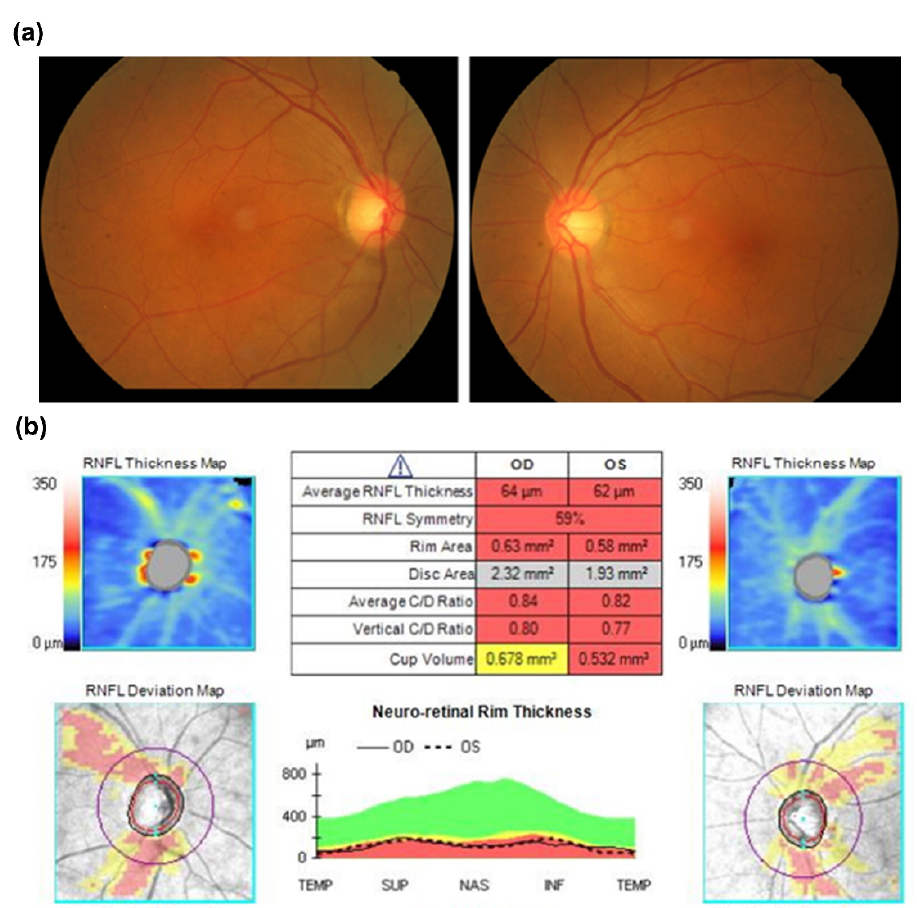
Figure 2. Pedigree and age of onset in each patient of Proband No. 12 family. Arrow: Proband No. 12.